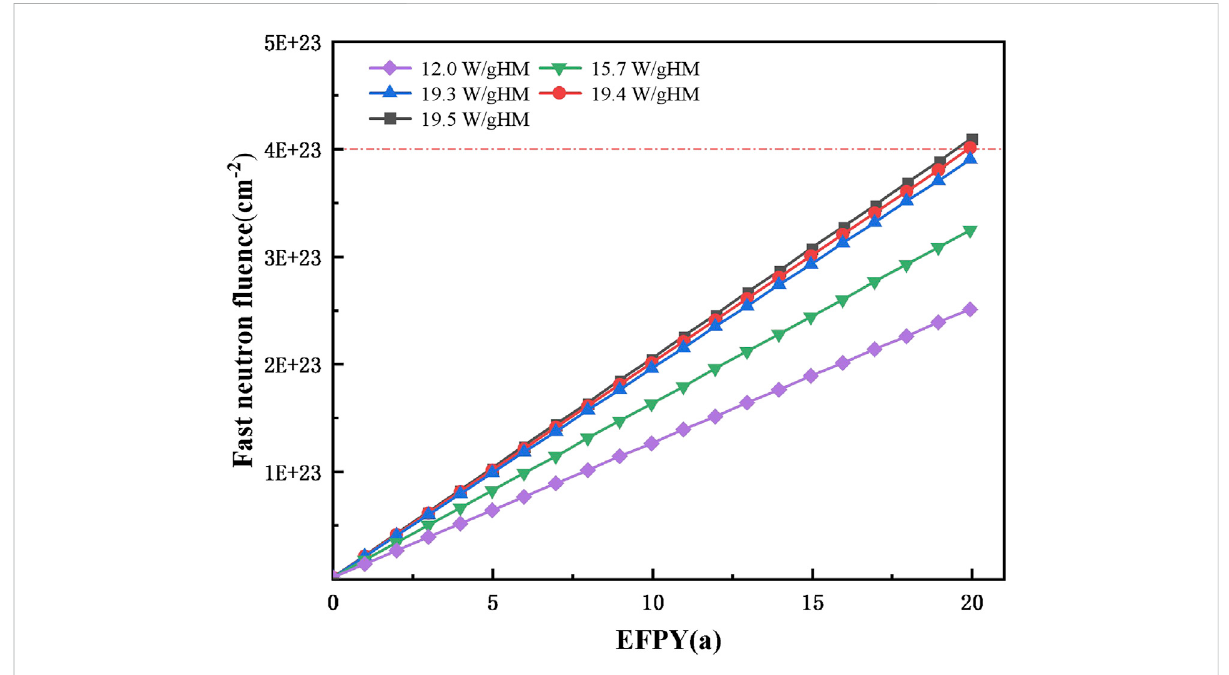
FIGURE 2 Fast neutron fl uence for different